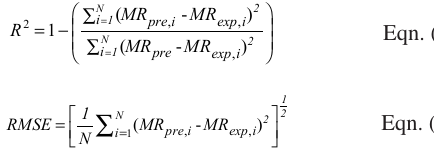
Drying rate ( dMR/dt )